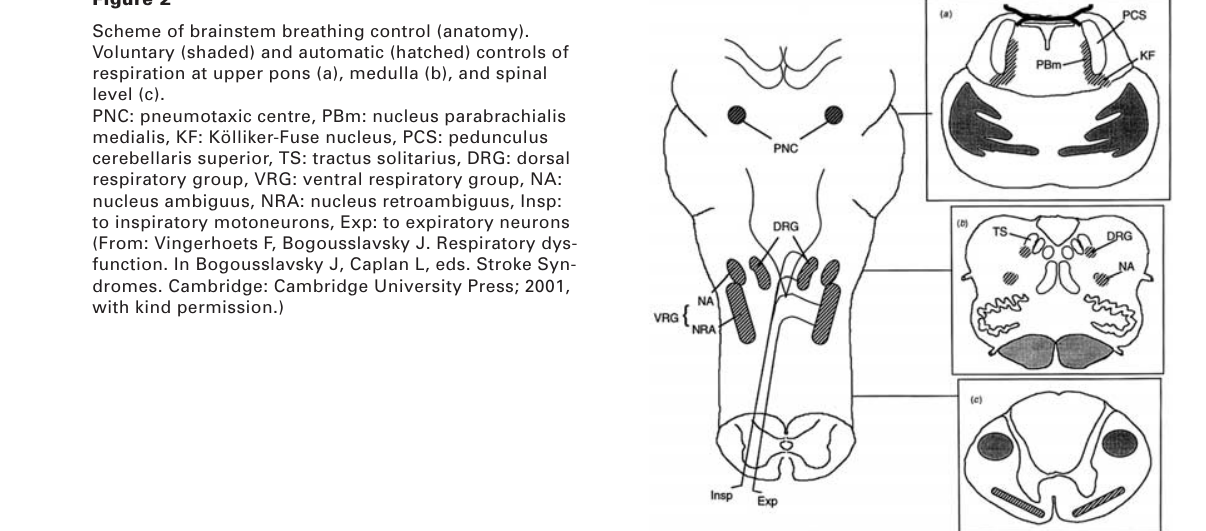
Scheme of brainstem breathing control (anatomy). Voluntary (shaded) and automatic (hatched) controls of respiration at upper pons (a), medulla (b), and spinal level (c). PNC: pneumotaxic centre, PBm: nucleus parabrachialis medialis, KF: Kölliker-Fuse nucleus, PCS: pedunculus cerebellaris superior, TS: tractus solitarius, DRG: dorsal respiratory group, VRG: ventral respiratory group, NA: nucleus ambiguus, NRA: nucleus retroambiguus, Insp: to inspiratory motoneurons, Exp: to expiratory neurons (From: Vingerhoets F, Bogousslavsky J. Respiratory dys- function. In Bogousslavsky J, Caplan L, eds. Stroke Syn- dromes. Cambridge: Cambridge University Press; 2001, with kind